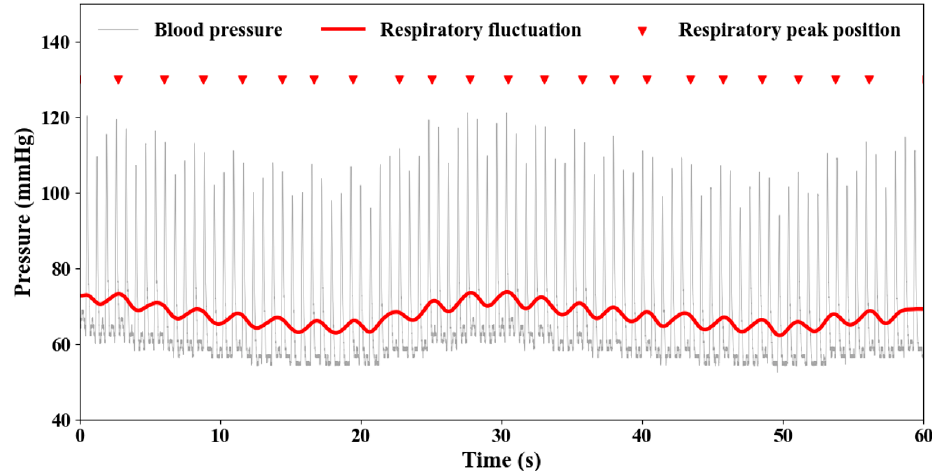
Figure 2. BP and RF waveforms extracted from a 12-year-old VSD patient in 1 min.